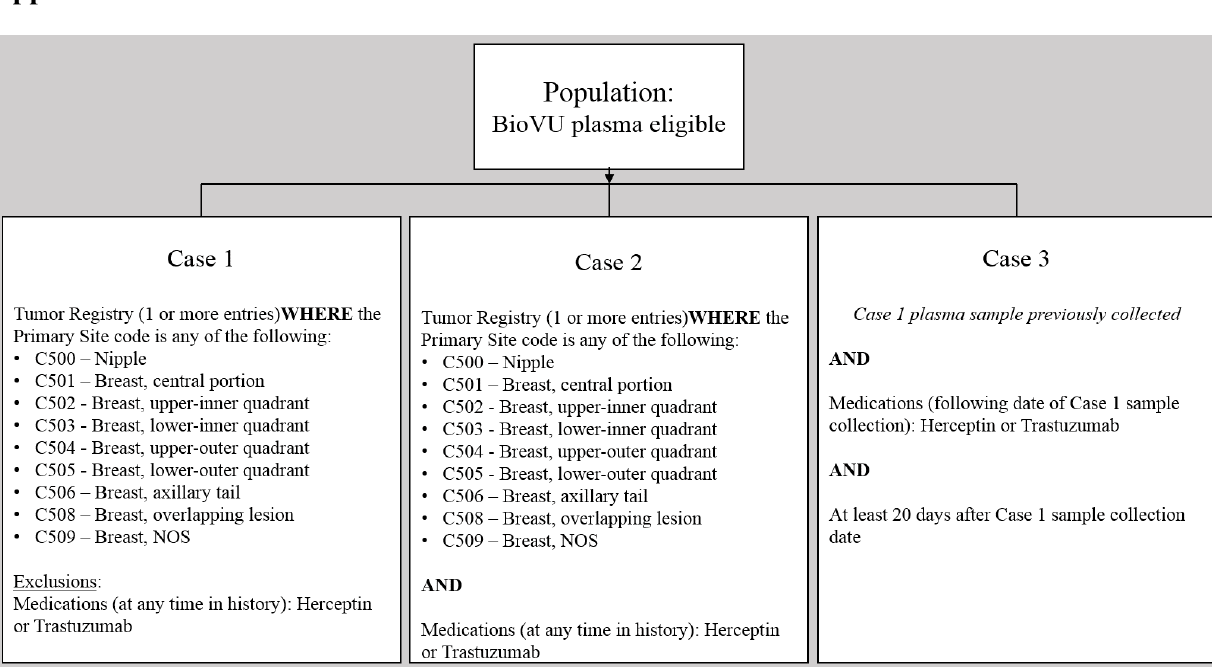
Figure A1. The sample plasma phenotype demonstrates clinical criteria used to define eligible samples in real